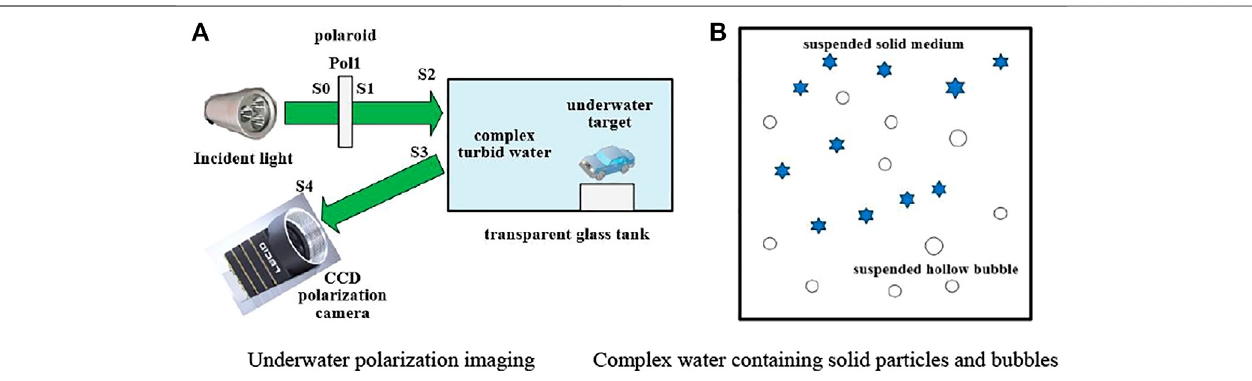
FIGURE 8 | The schematic diagram of underwater polarization imaging. (A) Underwater polarization imaging. (B) Complex water containing solid particles and bubbles.